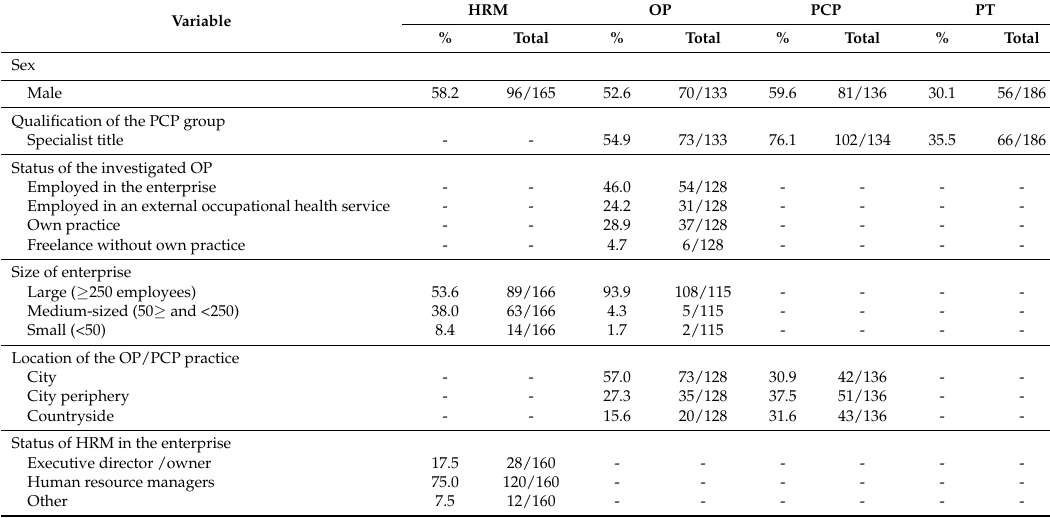
Table 1. Demographic characteristics of the study